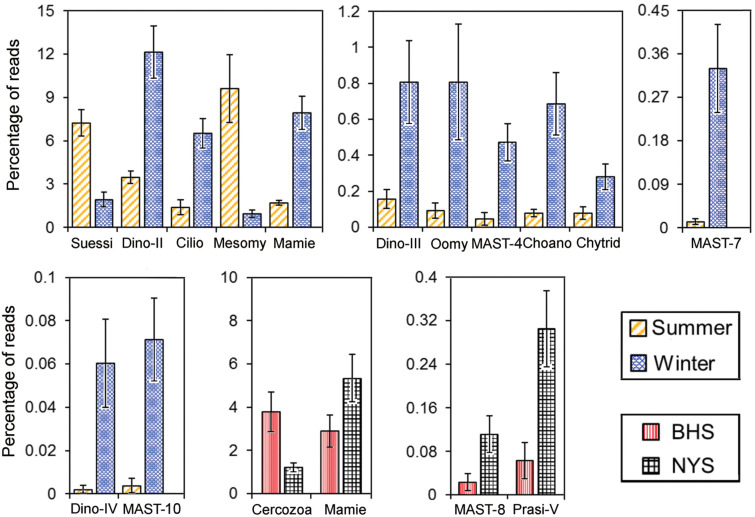
The pico-/nanoeukaryotic taxa of which the relative proportions were significantly different (P ≤ 0.05 by Student’s t-test or Mann–Whitney U test) between summer and winter, or between BHS and NYS. The error bars indicate standard errors. Asco, Ascomycota; Basidio, Basidiomycota; Choano, Choanoflagellida; Chytrid, Chytridiomycota; Cilio, Ciliophora; Crypto, Cryptophyta; Dino-II, Dino-Group-II; Dino-III, Dino-Group-III; Dino-IV, Dino-Group-IV; Labyri, Labyrinthulea; Mamie, Mamiellaceae; MASTs, marine stramenopiles; Mesomy, Mesomycetozoa; Oomy, Oomycota; Prasi-V, Prasino-Clade-V; Prym, Prymnesiales; Suessi, Suessiales.